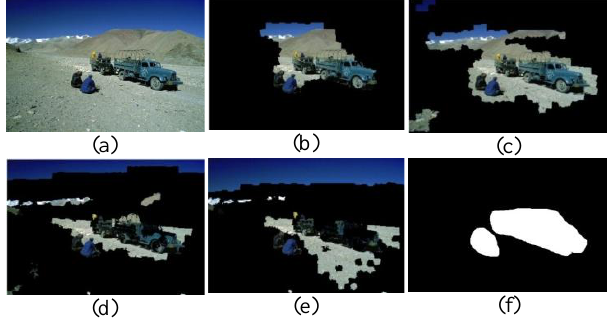
Figure 9. (a) original image, (b) SS&KD, (c) Rare2012, (d) Achanta 08, (e) Achanta 09, (f) human labeled